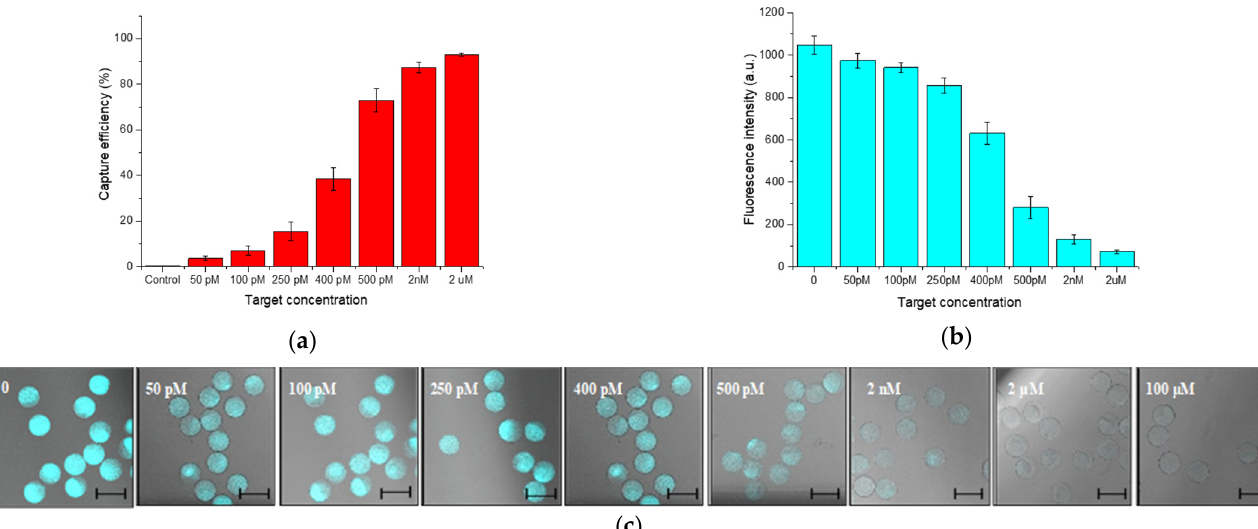
Figure 4. ( a ) MiR143-3p capture efficiency by Hydrogel beads assay and ( b ) corresponding fluorescence intensity turn-off ( c ) Images collected by CLSM for the target concentration analyzed (Scale bars: 100 μ m).